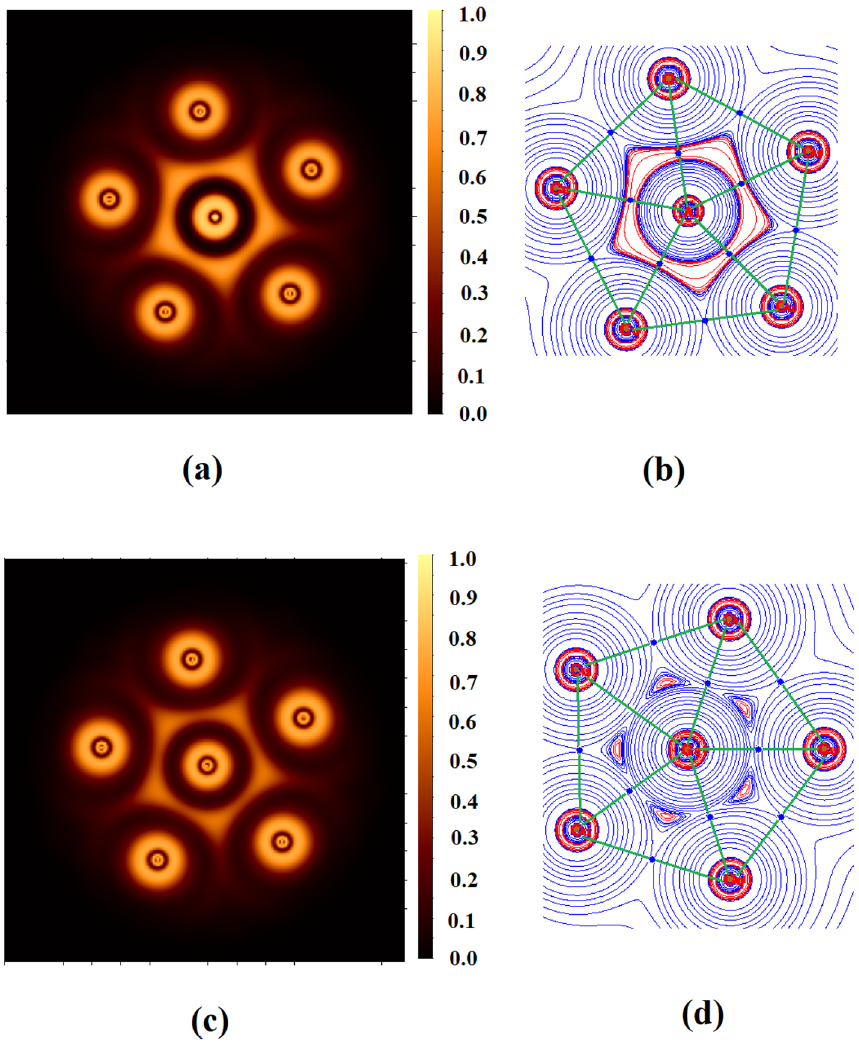
Figure 4. Plot of ( a ) laplacian of electron density (red = charge concentration, blue = charge depletion) and ( b ) electron localization function (ELF) in the molecular plane of Cu 5 Al 2+ and ( c ) and ( d ) are for Cu 5 Ga 2+